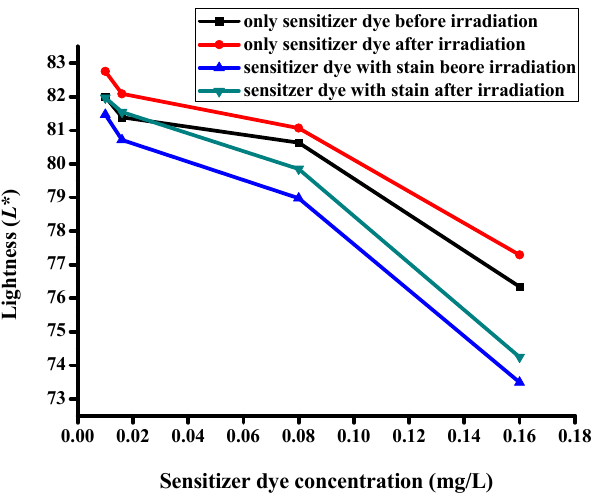
Figure 9. The L * values of dye/TiO 2 ‐ coated cotton fabric.